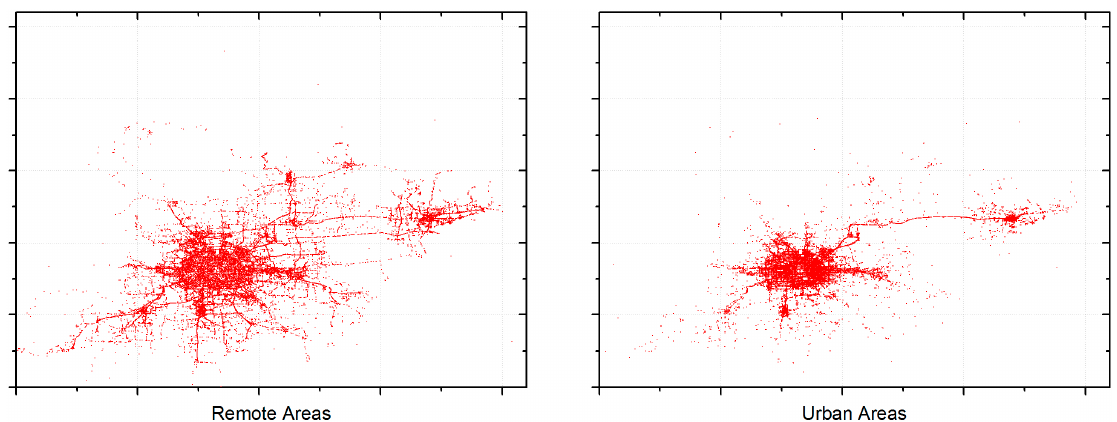
Figure 12. Distributions of remote and urban areas covered by uploaded data packets.